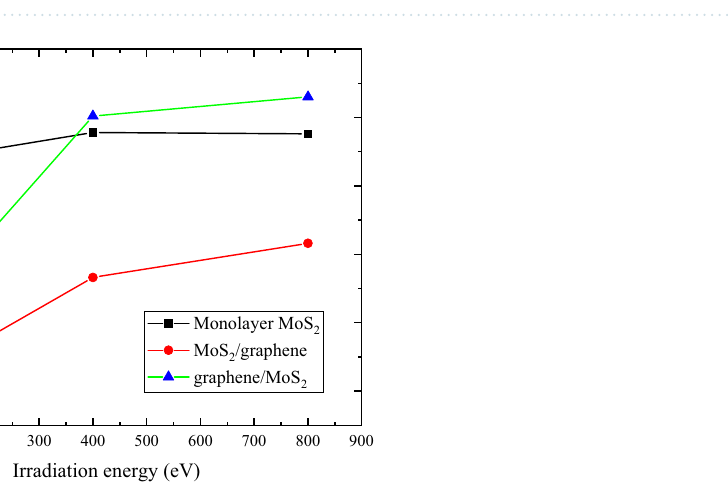
Figure 4. Comparison of the morphologies of MoS 2 under irradiation with low (40 eV) and high (400 eV) energies for the study cases of monolayer MoS 2 , MoS 2 /graphene heterostructure, and graphene/MoS 2 heterostructure.